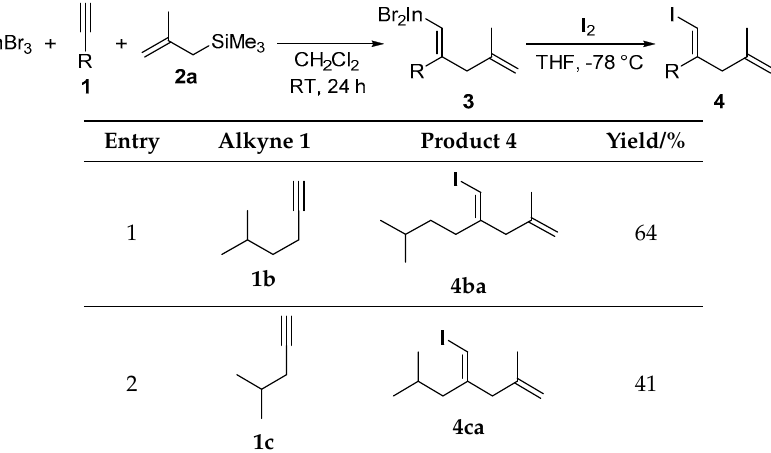
Table 2. Scope and limitation of alkyne 1 in allylindation a .